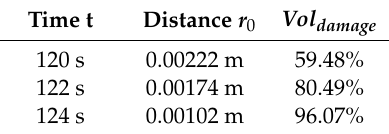
Table 5. The irreversible thermal damage of myxoid liposarcoma tumor at and voltage V = 34V.